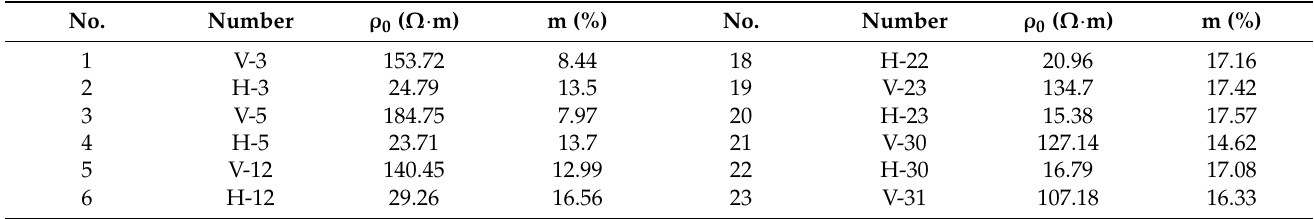
Table 4. Inversion results of core IP parameters under normal temperature and